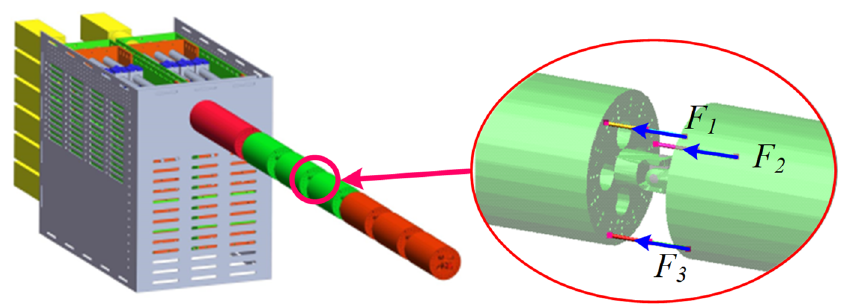
Figure 9. Simulation analysis of snake robot equivalent dynamic control.